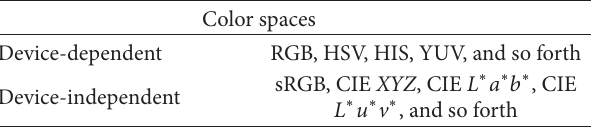
Table 1: The commonly used color spaces. Color